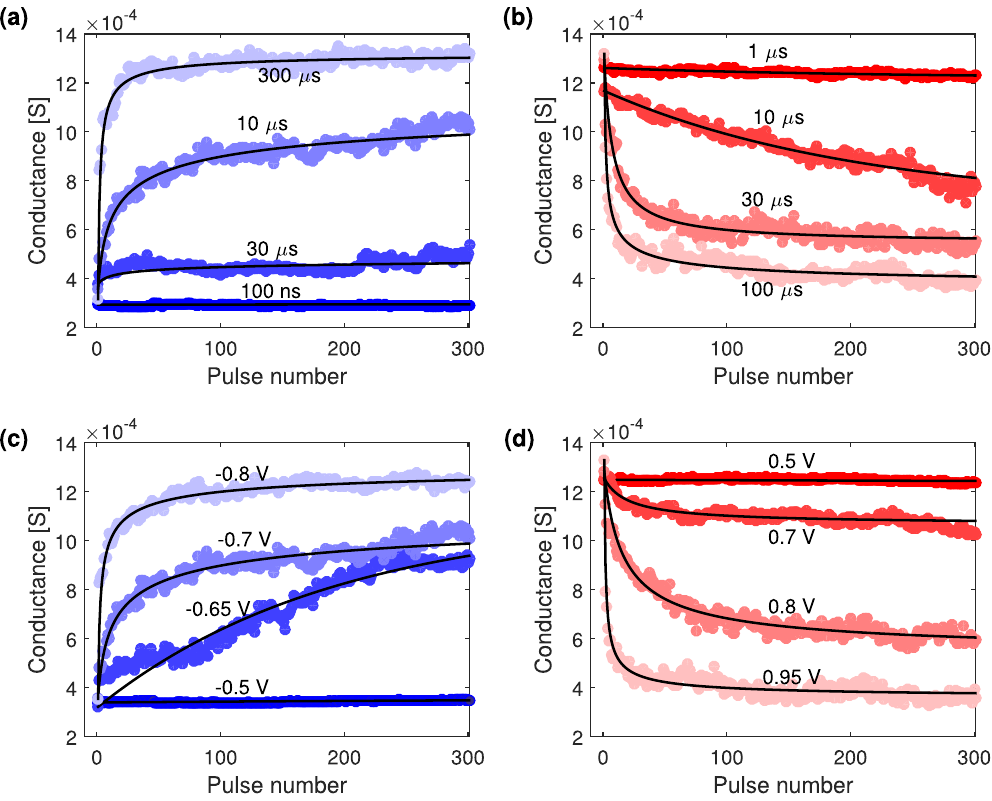
Figure 2. Sequences of 300 identical pulses for different programming conditions. In black lines, fit to data of the generalized soft bound model. ( a ) Potentiation operations for a fixed Δ V of − 0.7 V at different Δ t ; ( b ) Depression operations operated at Δ V = + 0.9 V and different Δ t ; ( c ) Potentiation curves obtained at Δ t = 10 μ s and different Δ V ; ( d ) Depression curves for Δ t = 100 μ s and different Δ V